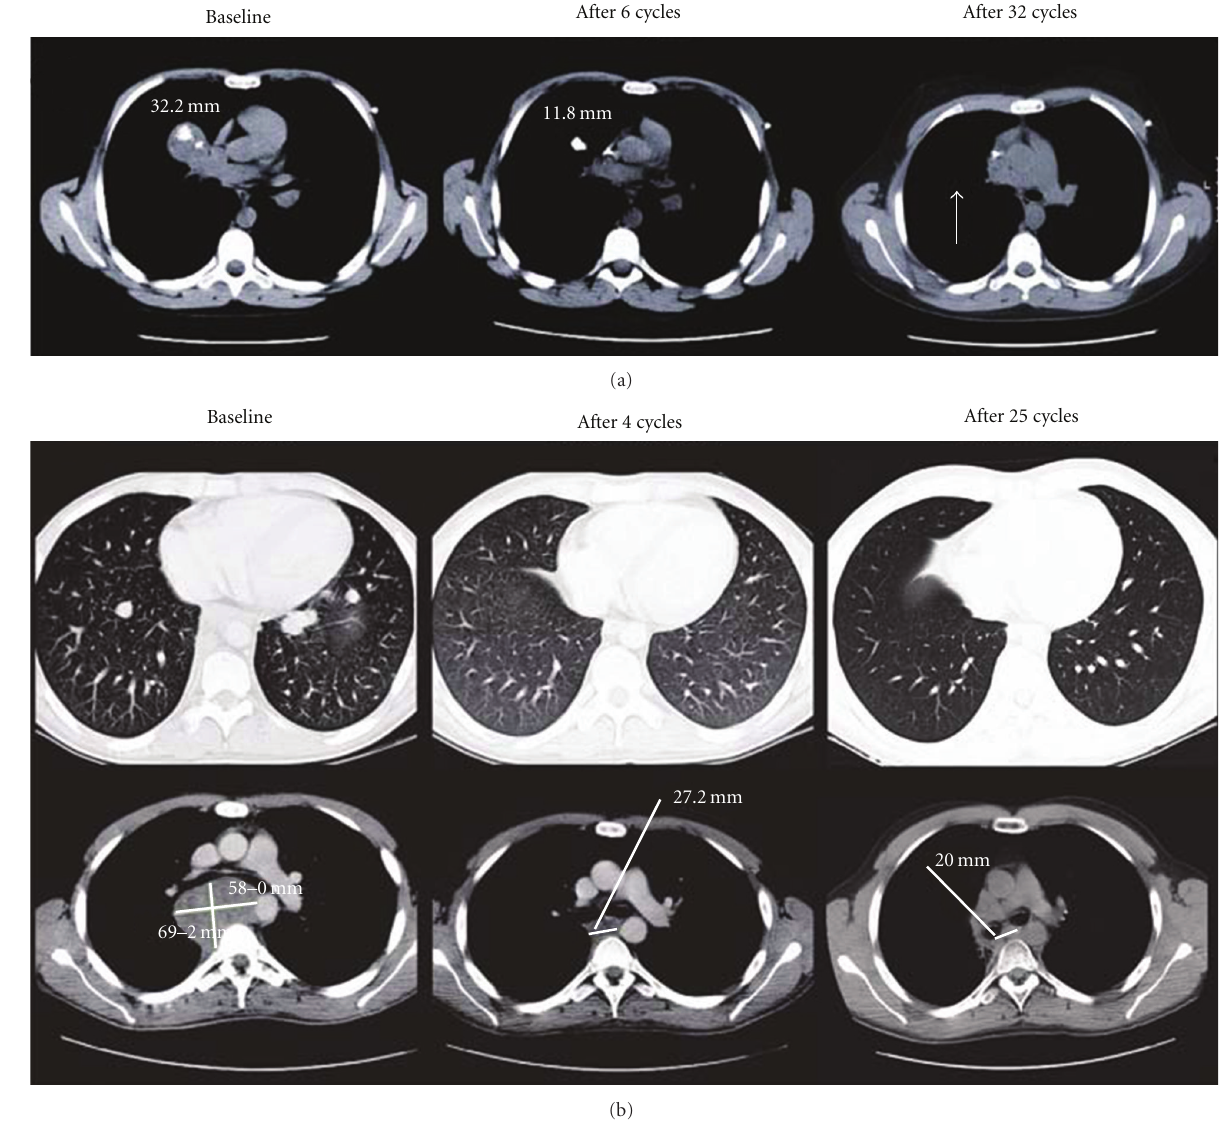
Figure 2: Confirmed responses to figitumumab in Ewing’s sarcoma. (a) This figure illustrates a response in a 12-year-old male patient with metastatic Ewing’s sarcoma treated with figitumumab 20 mg/kg every 4 weeks. The baseline, 6 and 32 cycle CT scans show a complete response (confirmed pathologically) in the target hilar mass and other subcentimeter lung nodules. (b) This figure illustrates a response in a 24-year-old male patient with metastatic extraskeletal Ewing’s sarcoma treated with figitumumab 20mg/kg every 4 weeks. The baseline and cycle 4 CT scan demonstrate complete eradication of several < 2cm lung metastases and a significant reduction in the mediastinal mass. The response to figitumumab was consolidated with 45 Gy in 15 fractions. The patient has an ongoing partial response after 25 cycles. (Adapted from